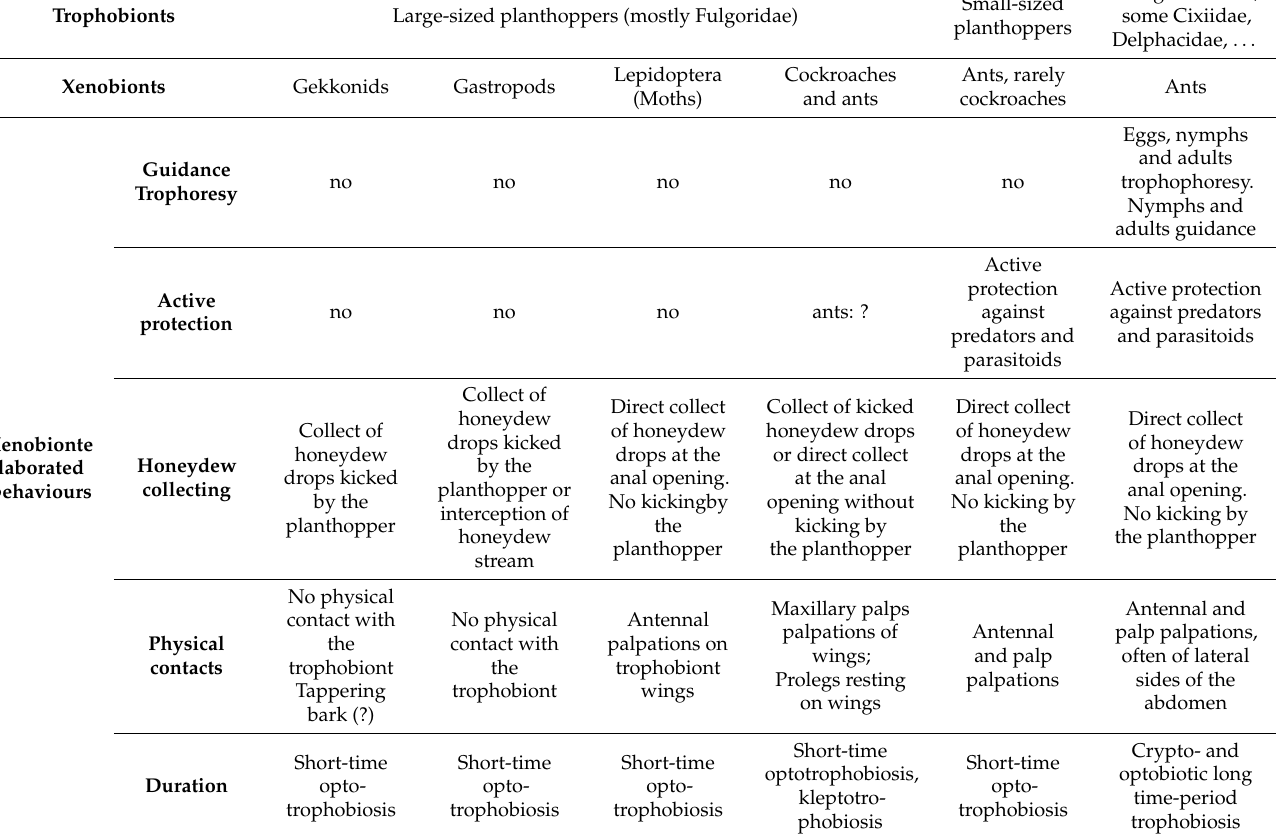
Table 3. Interaction diversity of xenobionts behaviours according to their taxonomic group and related to the size of the trophobiotic